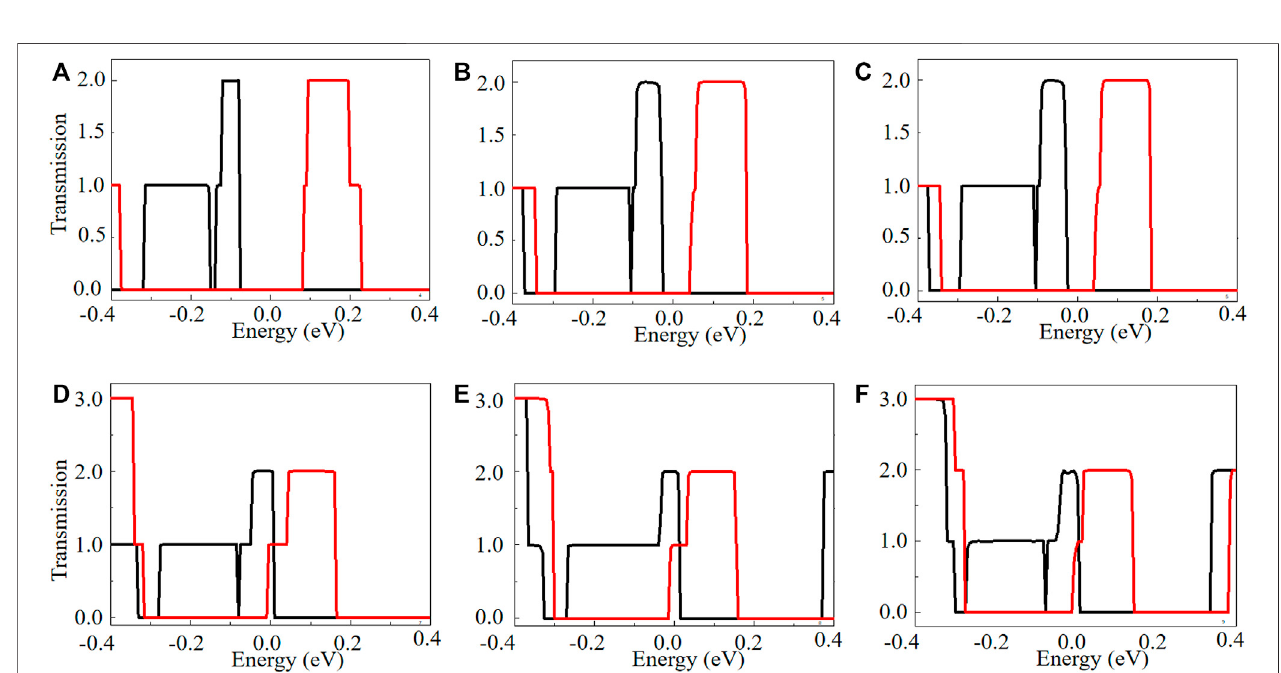
FIGURE 3 | Spin-related transmission spectrums of the N-ZKGeNRs (N = 4 – 9) devices, (A) N = 4, (B) N = 5, (C) N = 6, (D) N = 7, (E) N = 8, (F) N = 9, in which spin-up and spin-down are described by the solid black and red lines.